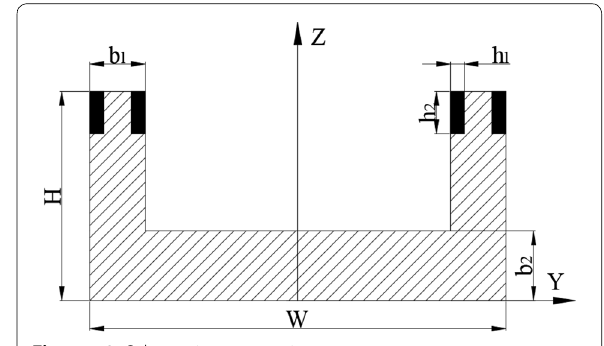
Figure 10 Schematic cross